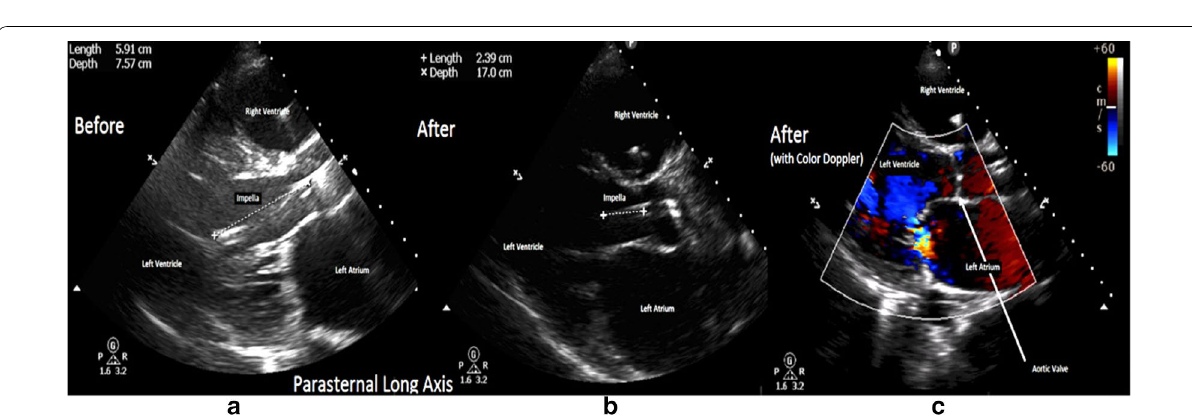
Fig. 2 Impella positioning visualized on the parasternal long-axis view on the TTE exam. a Images acquired at the time of improper positioning. The Impella ® (hyperechoic structure) is located 5.9 cm beyond the aortic valve in the left ventricle. b Acquired after repositioning. Notice that the length of the Impella ® in the left ventricle is now 2.4 cm beyond the aortic valve into the LV. c Acquired after repositioning with color Doppler. Flow at the outflow area can be visualized. The outflow area is now located above the aortic